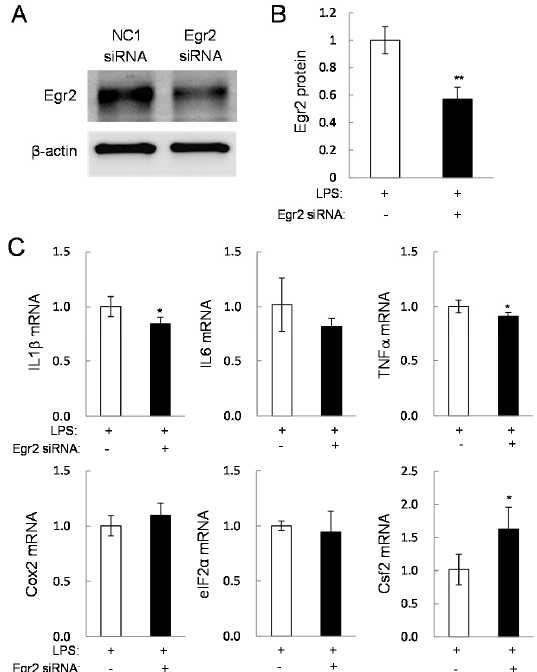
Figure 5. Effects of a partial silencing of Egr2 on the mRNA levels of the selected genes in LPS-stimulated RAW264.7 cells. The single and double asterisk indicates p < 0.05 and p < 0.01, respectively. ( A , B ) Reduction of Egr2 by treatment with Egr2 siRNA; ( C ) levels of IL1 β , IL6, TNF α , Cox2, eIF2 α , and Csf2 mRNAs in response to Egr2 siRNA treatment in LPS-stimulated RAW264.7 cells.